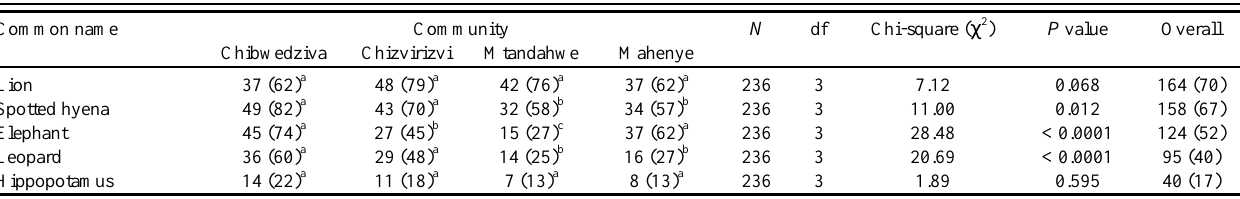
Table 5 . Differences and similarities among the four communities on the disliked animal species. Values are number of respondents, and percentages in parentheses; N : sample size; df: degrees of freedom. Total percentage exceeds 100 for each community because the respondents were allowed to give multiple answers. Values with different superscript letters within rows differ significantly (Z tests; P < 0.05).